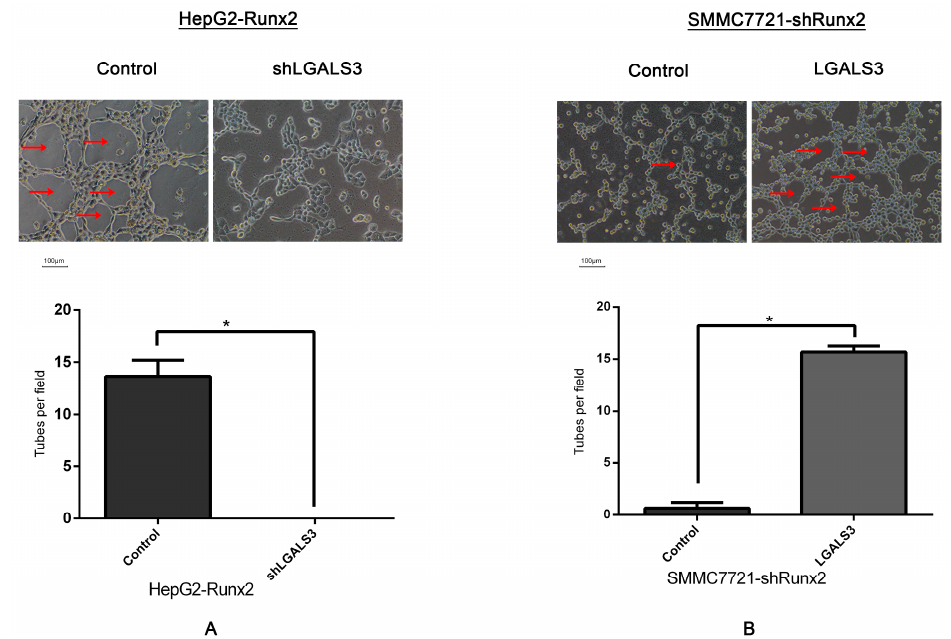
Figure 8. Three-dimensional culture on Matrigel matrix (×200; bars 100 µm), VM-like tubes are pointed by Red arrows. ( A ) VM-like tube formations disappear in HepG2-Runx2-shLGALS3 compared with HepG2-Runx2-control cells; ( B ) increased number of VM formation of SMMC7721-shRunx2-LGALS3 compared with SMMC7721-shRunx2-control cells (* p < 0.05).